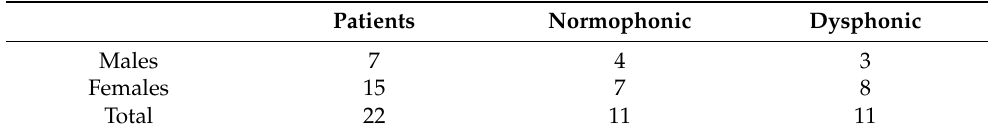
Table 1. Summary of patients participating in the study by gender and normophonic/dysphonic subjects.